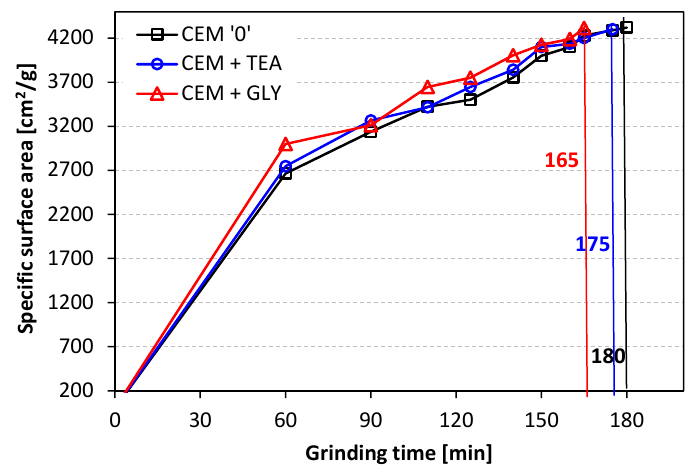
Figure 1. Specific surface area of cements vs. grinding time. The grain size distribution of cements with grinding aids is narrowed, compared with the reference cement without additives, which means that size of their grains is more homogeneous (Figure 2). Slight differences can be noticed in the range of 10 ÷ 40 µm, where CEM ‘0’ has about 30% fewer grains, compared with CEM + TEA and CEM + GLY. However, the control cement contains more fine grains, within the range of 2 ÷ 10 µm. It can be said that the grain size distribution of CEM + TEA and CEM + GLY cements is slightly shifted towards smaller grain sizes.